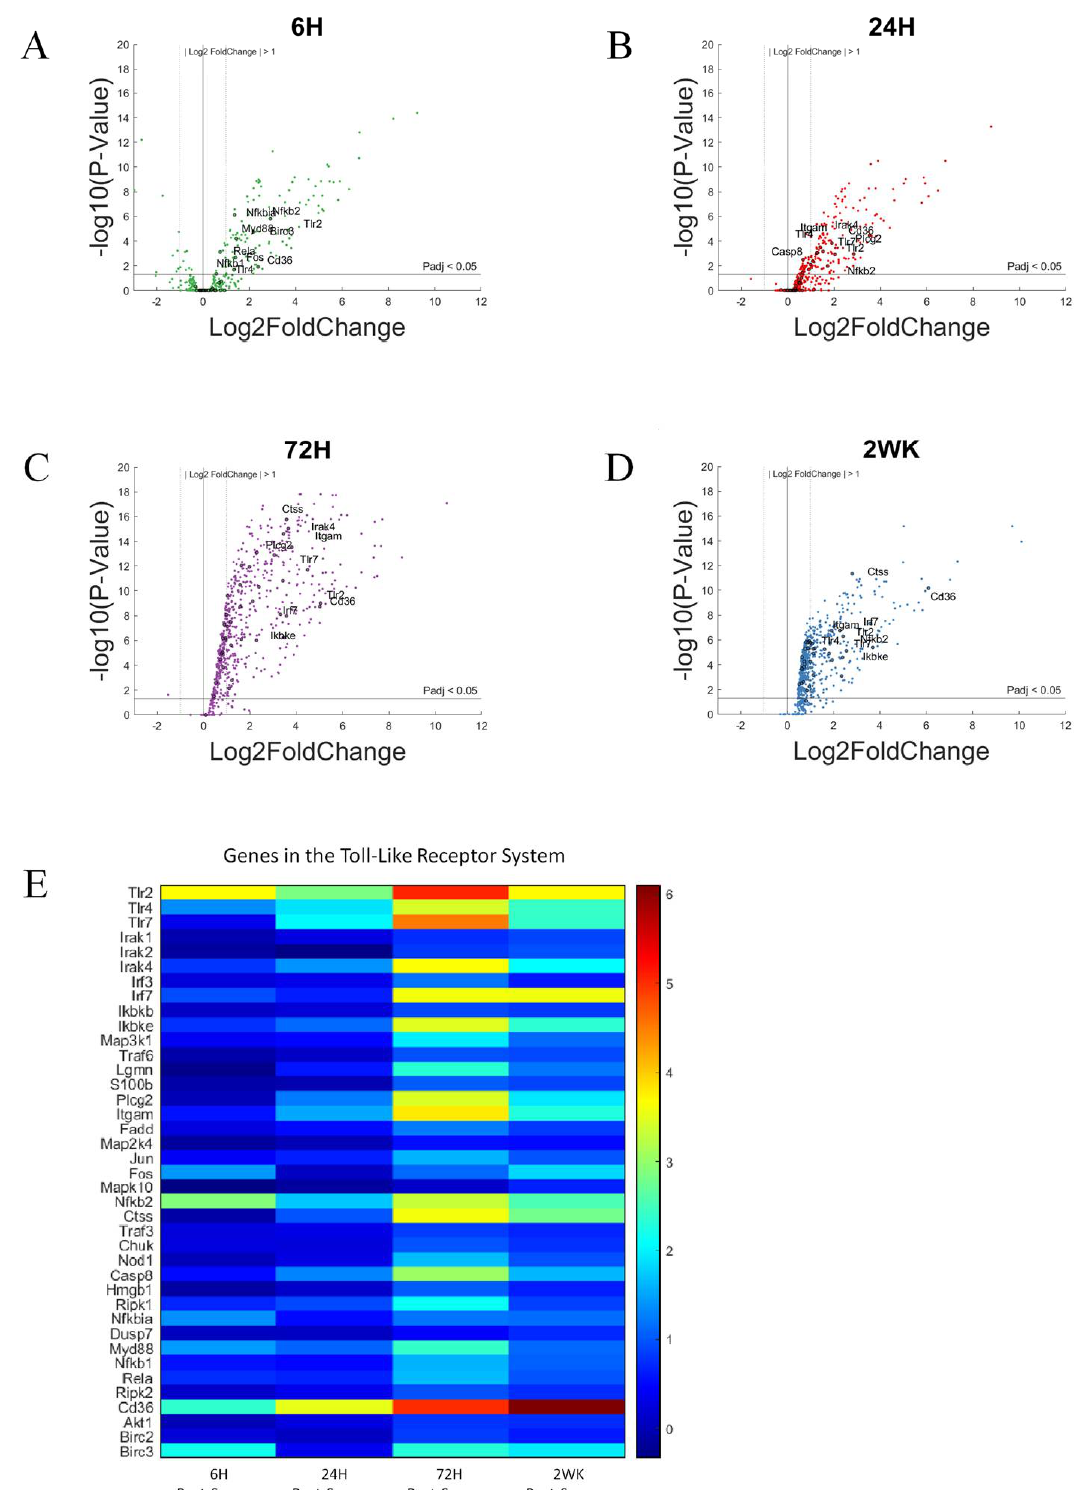
Figure 7. Differential expression of gene set involved in the Toll-like receptor pathway compared to NSCTR mice: ( A ) volcano plot with genes in the TLR group shown in black circles. Top 10 genes by differential expression level and P adj < 0.05 are labeled. Each time point post-surgery is on a separate volcano plot. ( A ) =6-h, ( B ) =24-h, ( C ) =72-h, and ( D ) =2-weeks. Color in ( A – D ) corresponds to time post-surgery color coding in other figures. ( E ) heatmap showing differential expressions of genes of the TLR system at each time point post-surgery compared to